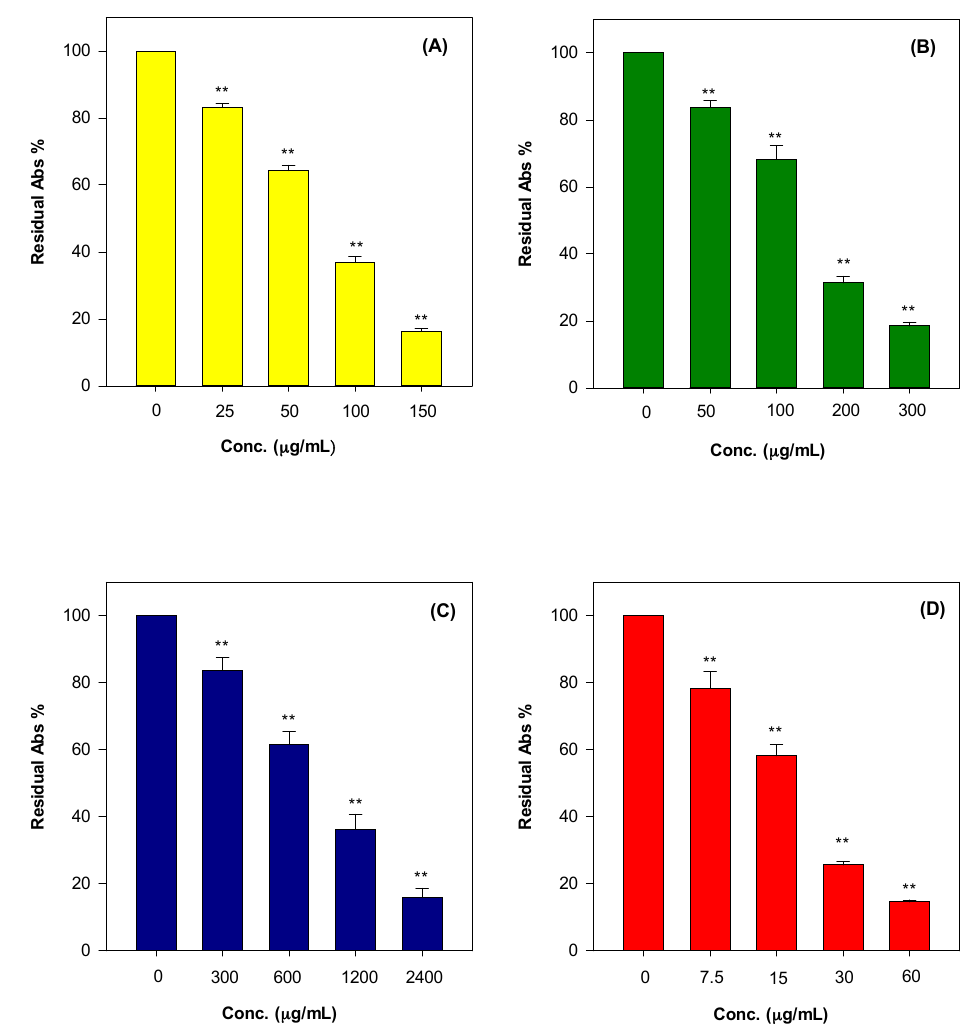
Figure 1. Antioxidant and free radical-scavenging activity of hull essential oil of Pistacia vera L. variety Bronte (HEO) towards Fe 3+ -TPTZ ( A ); ABTS • + ( B ); DPPH • ( C ); and iron chelating capacity ( D ). The asterisks (**) indicate significant differences ( p < 0.05).